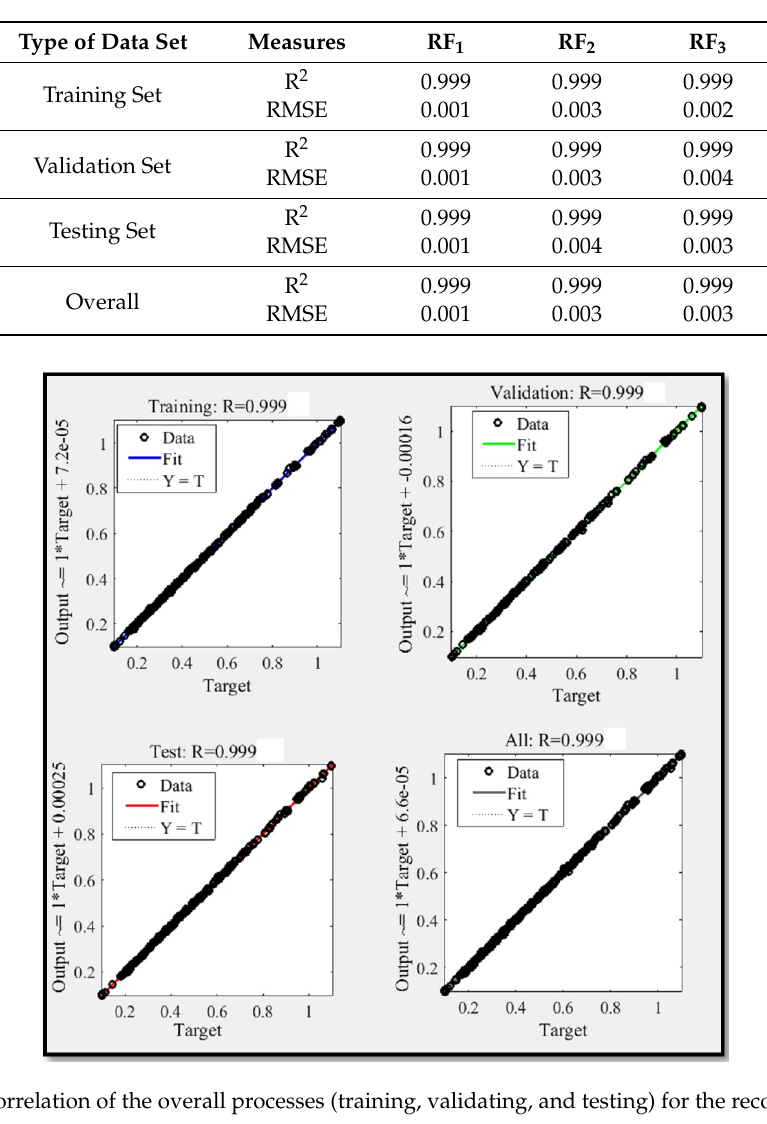
Table 6. Performance of ANN modeling in all processes.